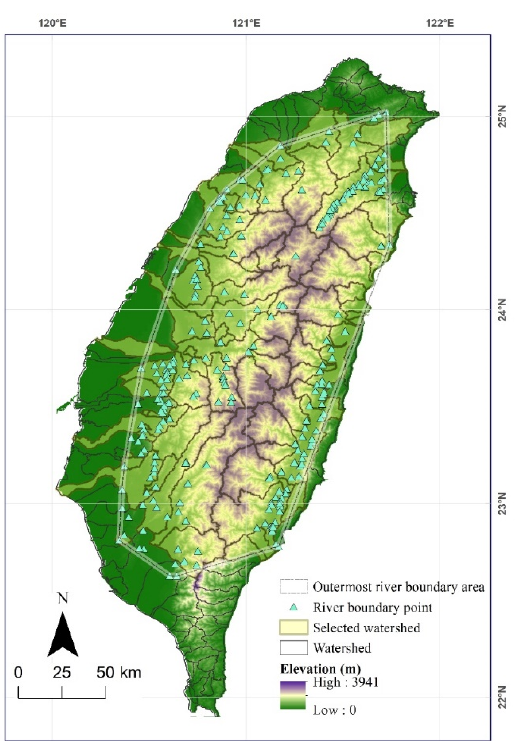
Figure A1. Spatial distribution of the upstream watersheds.